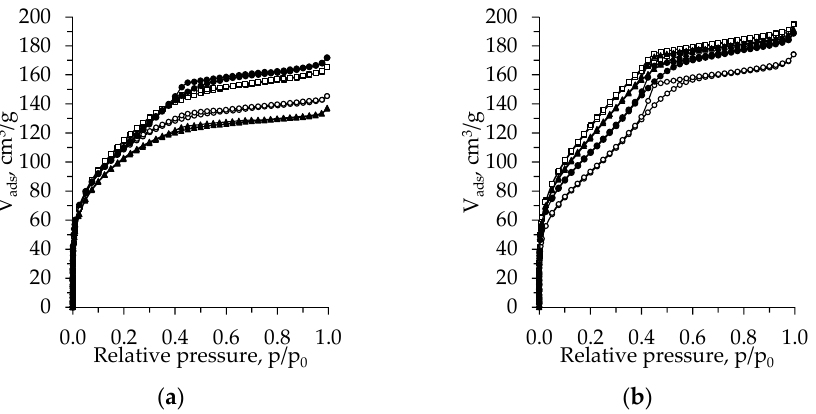
—nH, (cid:78) —cH, (cid:3) —DE) and (cid:35)